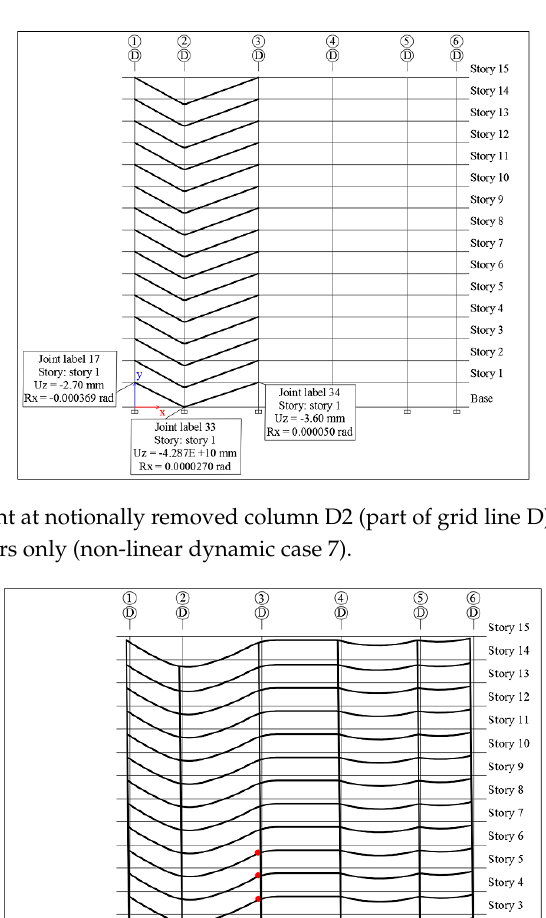
Figure 11. Displacement response at the location of removed column D2 when moment frames are located at perimeters and along grid lines B, C, D, E, F and G (non-linear dynamic case 19).